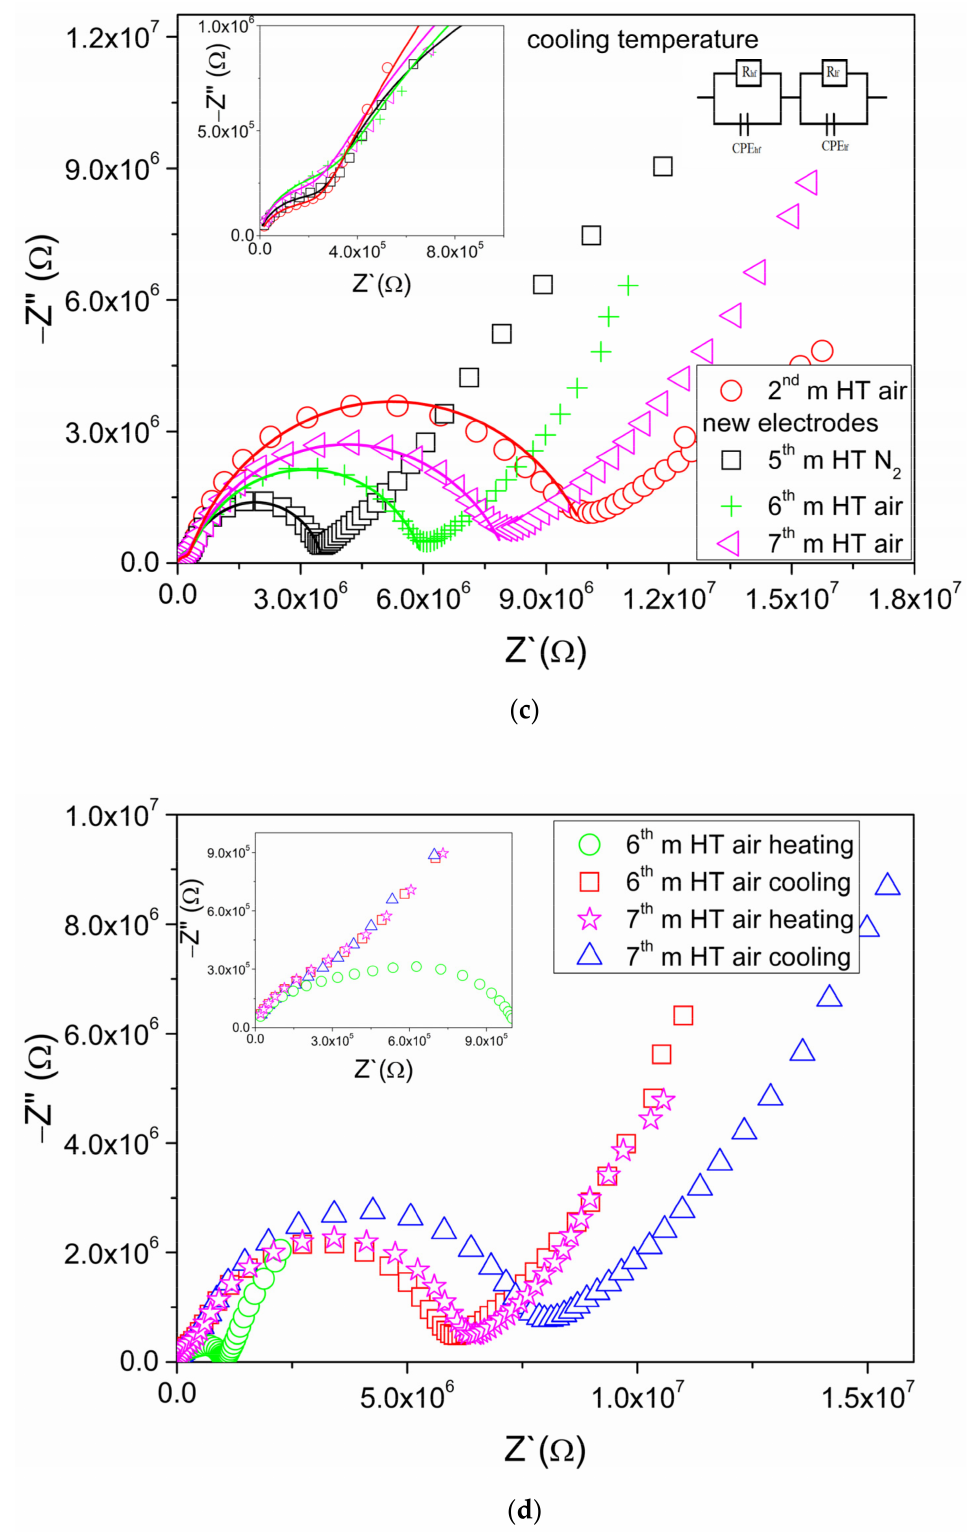
Figure 3. The comparison of Nyquist plots at an exemplar temperature of 383 K for: ( a ) 1st m LT,